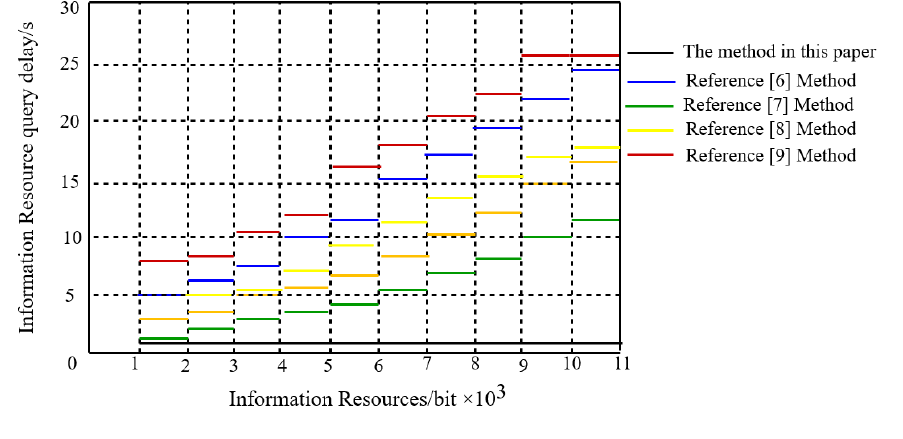
Figure 5. Privacy information query latency.